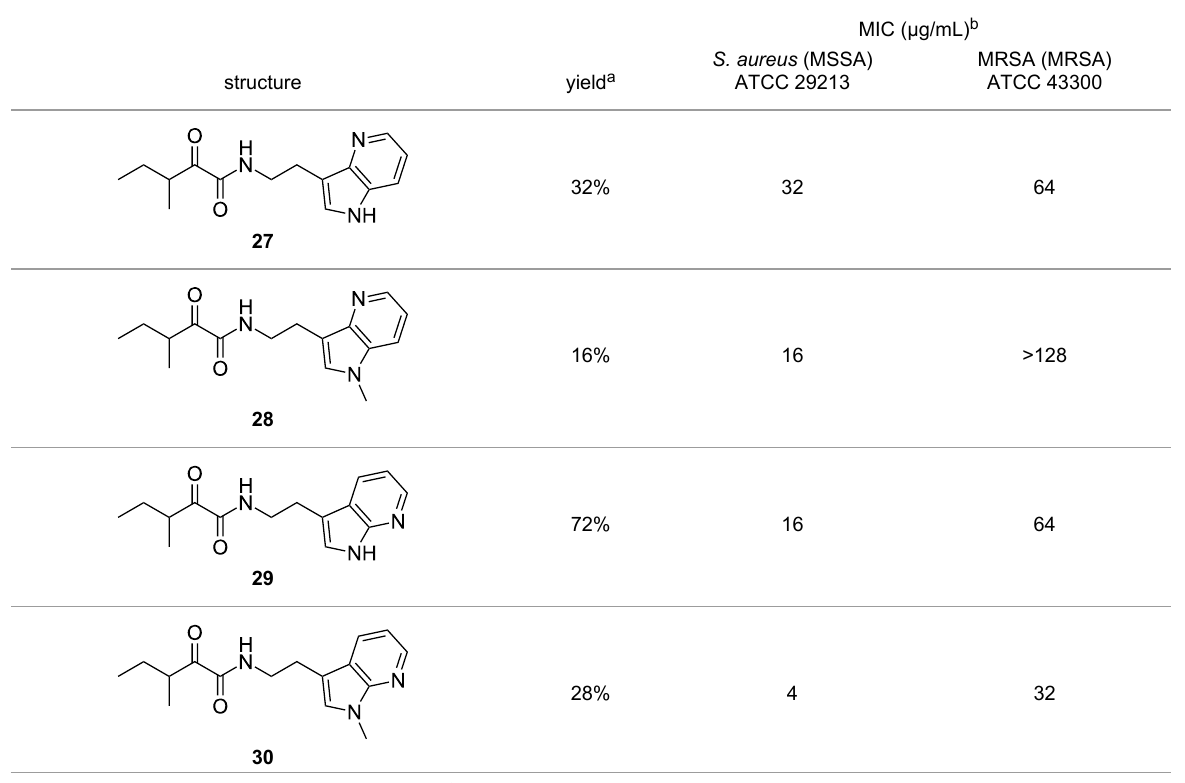
Table 2: Summary of synthesized nematophin derivatives ( 27 – 30 ) and their bioactivity (MIC in µg/mL) against S. aureus (MSSA and